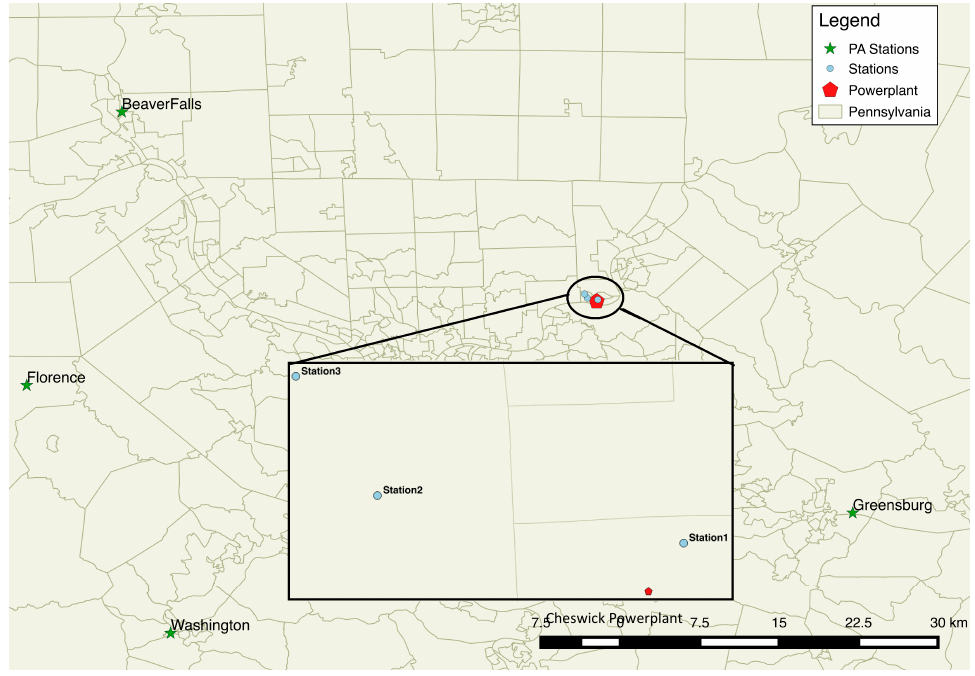
Figure 2. Location of the PA DEP monitoring sites in relation to the NCSU monitoring stations. The PA DEP monitoring sites are represented by the green stars while the NCSU monitoring sites are represented by the blue dots.